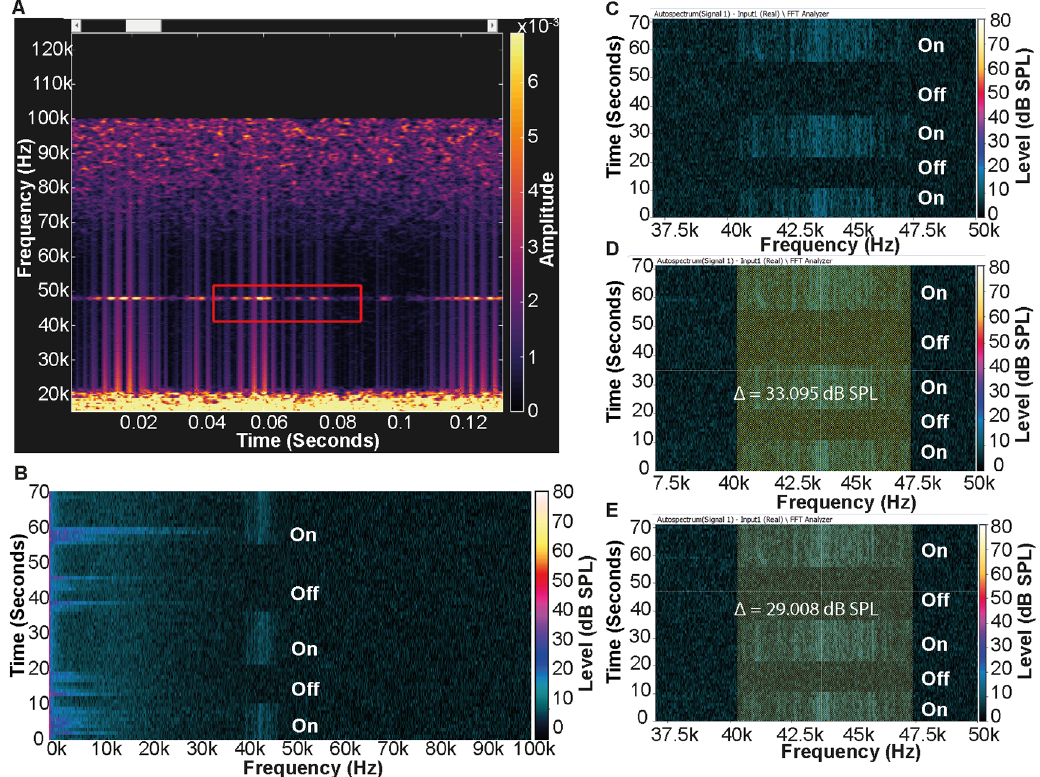
Figure1.Spectrogramofthenoiseproducedbytheceilinglights. A)Noiseproducedbythelightsishighlightedin theredbox.SpectrogramproducedusingDeepSqueak(2.6.0) 36